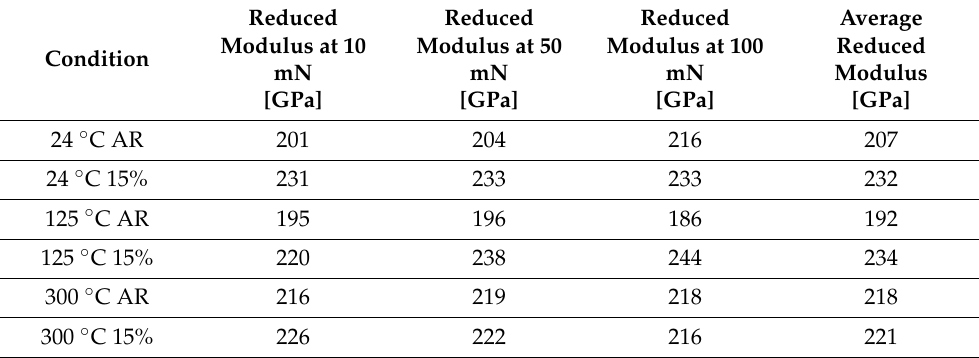
Table 5. Averaged reduced modulus for 10 mN; 50 mN and 100 mN force, as used for